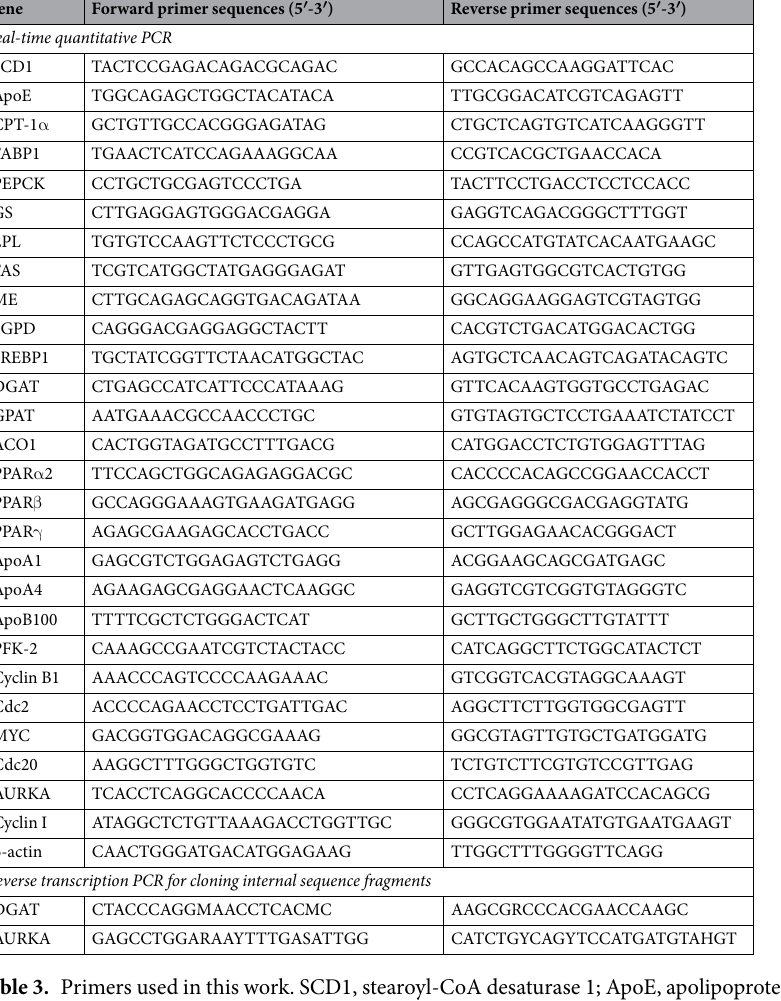
Table 3. Primers used in this work. SCD1, stearoyl-CoA desaturase 1; ApoE, apolipoprotein E; CPT-1 α , carnitine O-palmitoyltransferase-1 α ; FABP1, fatty acid-binding proteins 1; PEPCK, phosphoenolpyruvate carboxykinase; GS, glycogen synthase; LPL, lipoprotein lipase; FAS, fatty acid synthetase; ME, malic enzyme; 6GPD, glucose-6-phosphate dehydrogenase; SREBP1, sterol-regulatory element binding proteins 1; DGAT, diacylglycerol acyl transferase; GPAT, glycerol-3-phosphate acyltransferase; ACO1, acyl-CoA oxidase 1; PPAR, peroxisome proliferator-activated receptor; PFK-2,6-phosphofructo-2-kinase (PFK-2); Cyclin B1, G2/mitotic- specific cyclin-B1; Cdc2, cyclin-dependent kinase 1 (CDK1); MYC, myc proto-oncogene protein; Cdc20, Cell division cycle protein 20; AURKA, aurora kinase